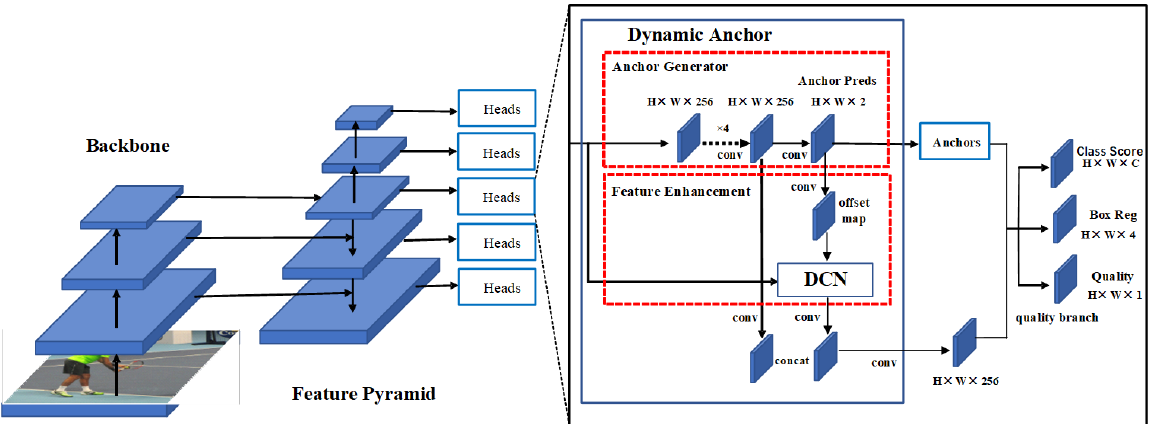
Figure 2. Illustration of our framework. In dynamic anchor, we employ the anchor generator, a fully convolutional branch to predict the best anchor shape for each location in the feature maps. Then the feature enhancement module is used to enhance feature expression. Finally, we propose the quality branch to suppress low-quality anchors.